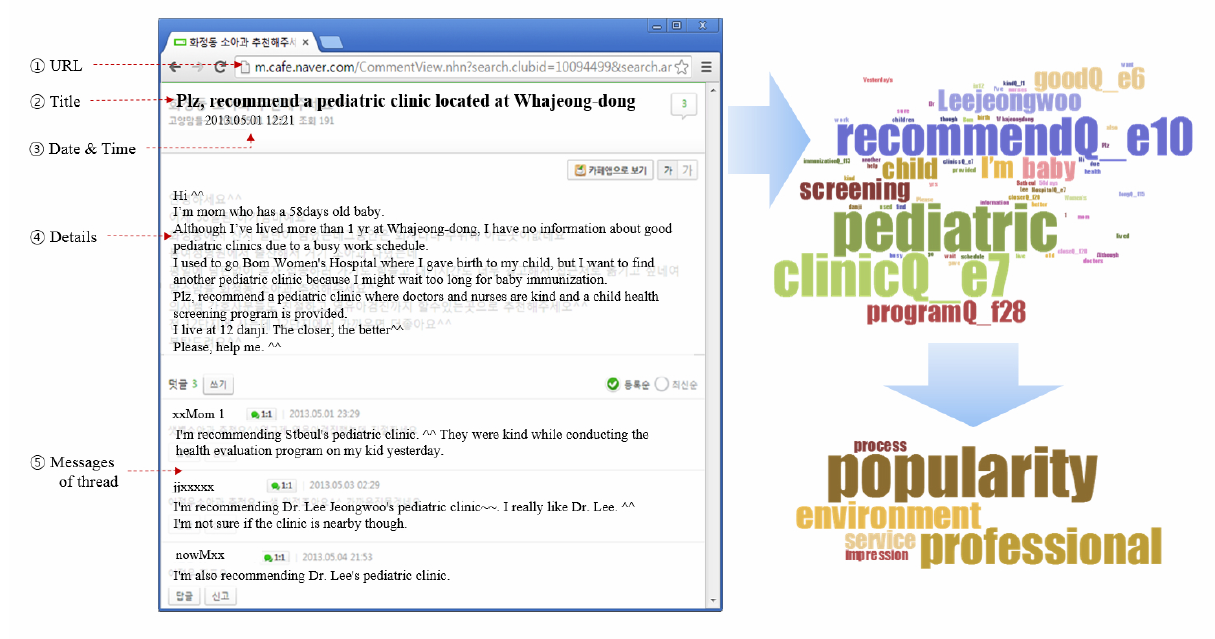
Figure 1. An example of online community and extracted quality factors for